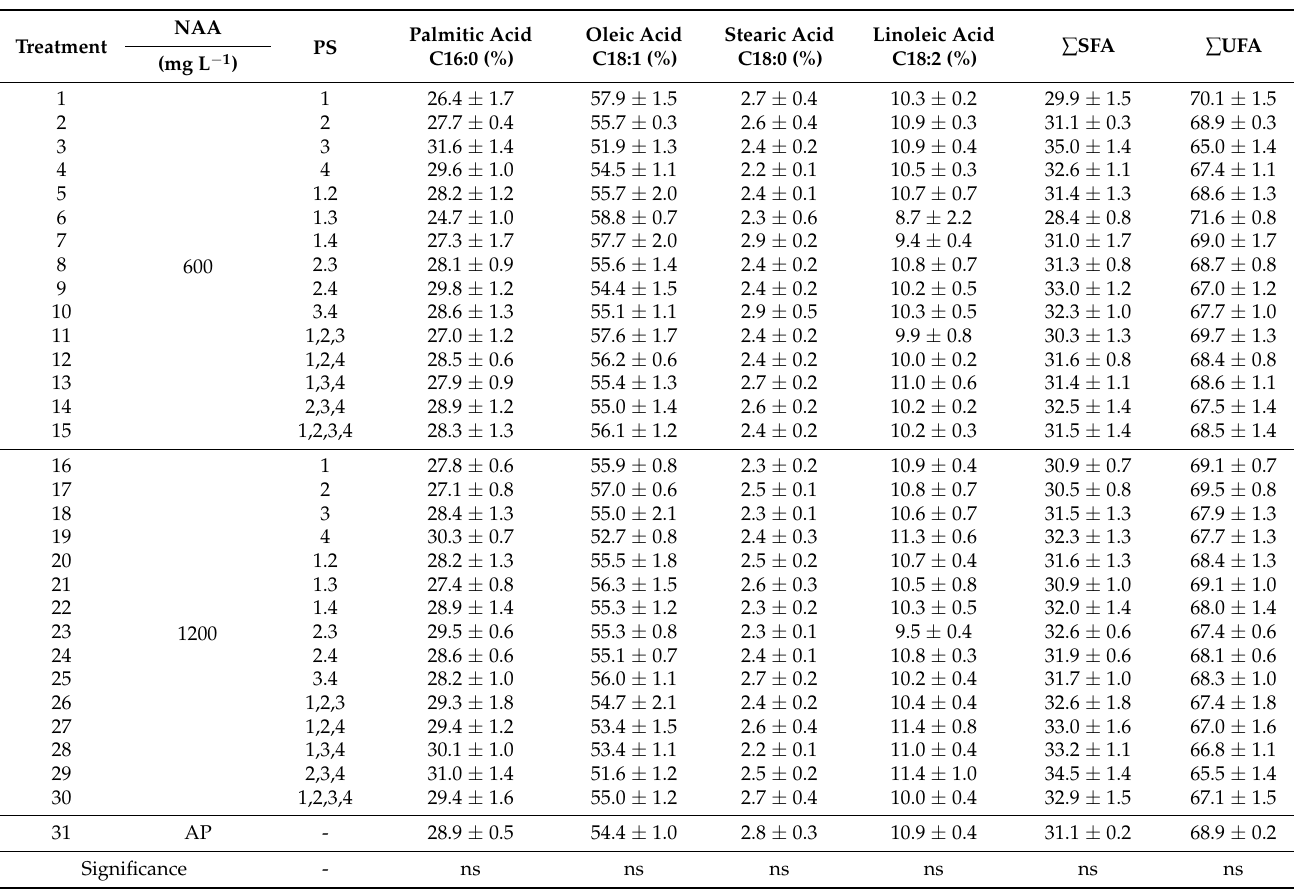
Table 6. Fatty acid profile in OxG hybrids (Coari x La M é ) treated with 600 mg L − 1 or 1200 mg L − 1 NAA for the induction of parthenocarpy. The NAA solutions were applied one, two, three, or four times at different phenological stages (603, 607, 609, 703). Assisted pollination treatment was performed only in inflorescences in anthesis (phenological stage 607). NAA Palmitic Acid Treatment PS C16:0